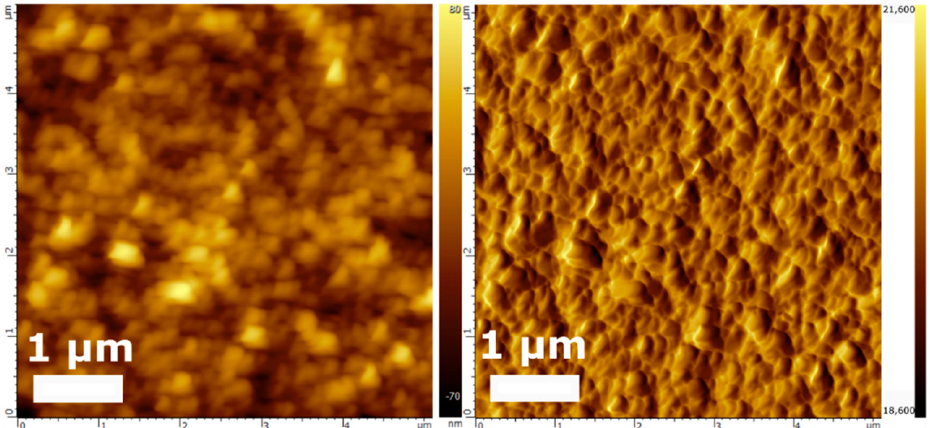
Figure 5. AFM images of LiCoO 2 thin film annealed at 550 ◦ C for 1 h 20 min in Ar Figure 5 . AFM images of LiCoO 2 thin film annealed at 550 °C for 1 h 20 min in Ar atmosphere.